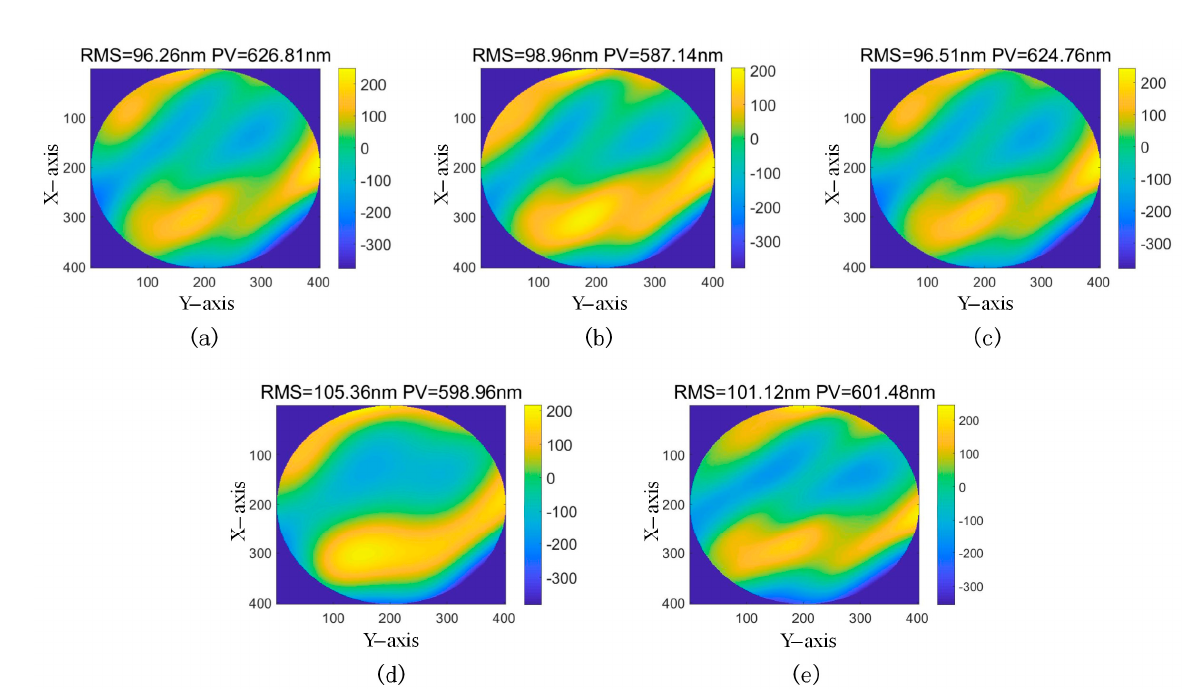
Table 3. Experiment results of the planar window glass and the optical planar element. Unit: nm.